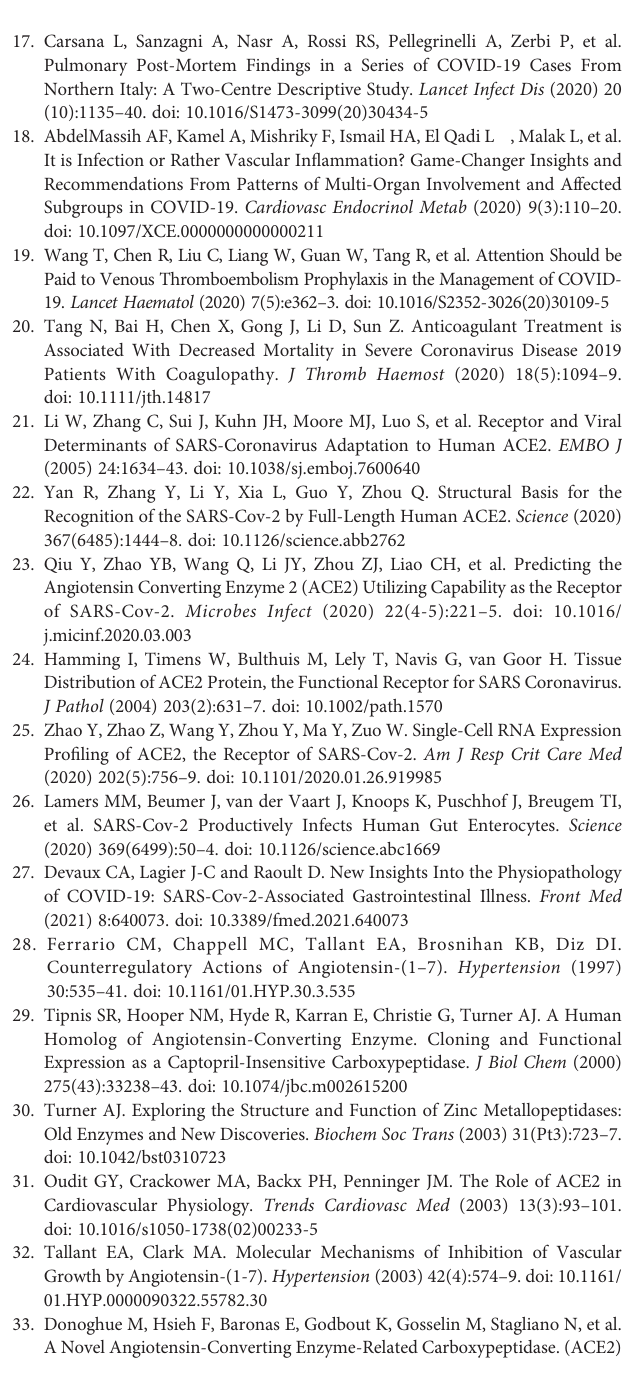
Supplementary Figure 2 | Correlation matrix (R studio used to generate the matrix) between sACE2 and angiotensin metabolites in different groups of COVID- 19 patients and healthy volunteers. The upper panels show the correlation matrix of the different biomarkers of interest for the group of healthy volunteers (left) and prolonged viral shedders (right), while the correlation matrix for the short viral sheddersisshowninthelowerleftpanel.Forthenotnormallydistributedcorrelation (Healthy control and prolonged viralshedders) we used Spearman ’ scorrelation and fortheshortviralsheddersweusedthePearson ’ scorrelation.Thetableatthelower right part of the fi gure summarizes the correlation analyses (Pearson test) between sACE2 and the different metabolites Ang I, Ang II, Ang-(1-7) in each